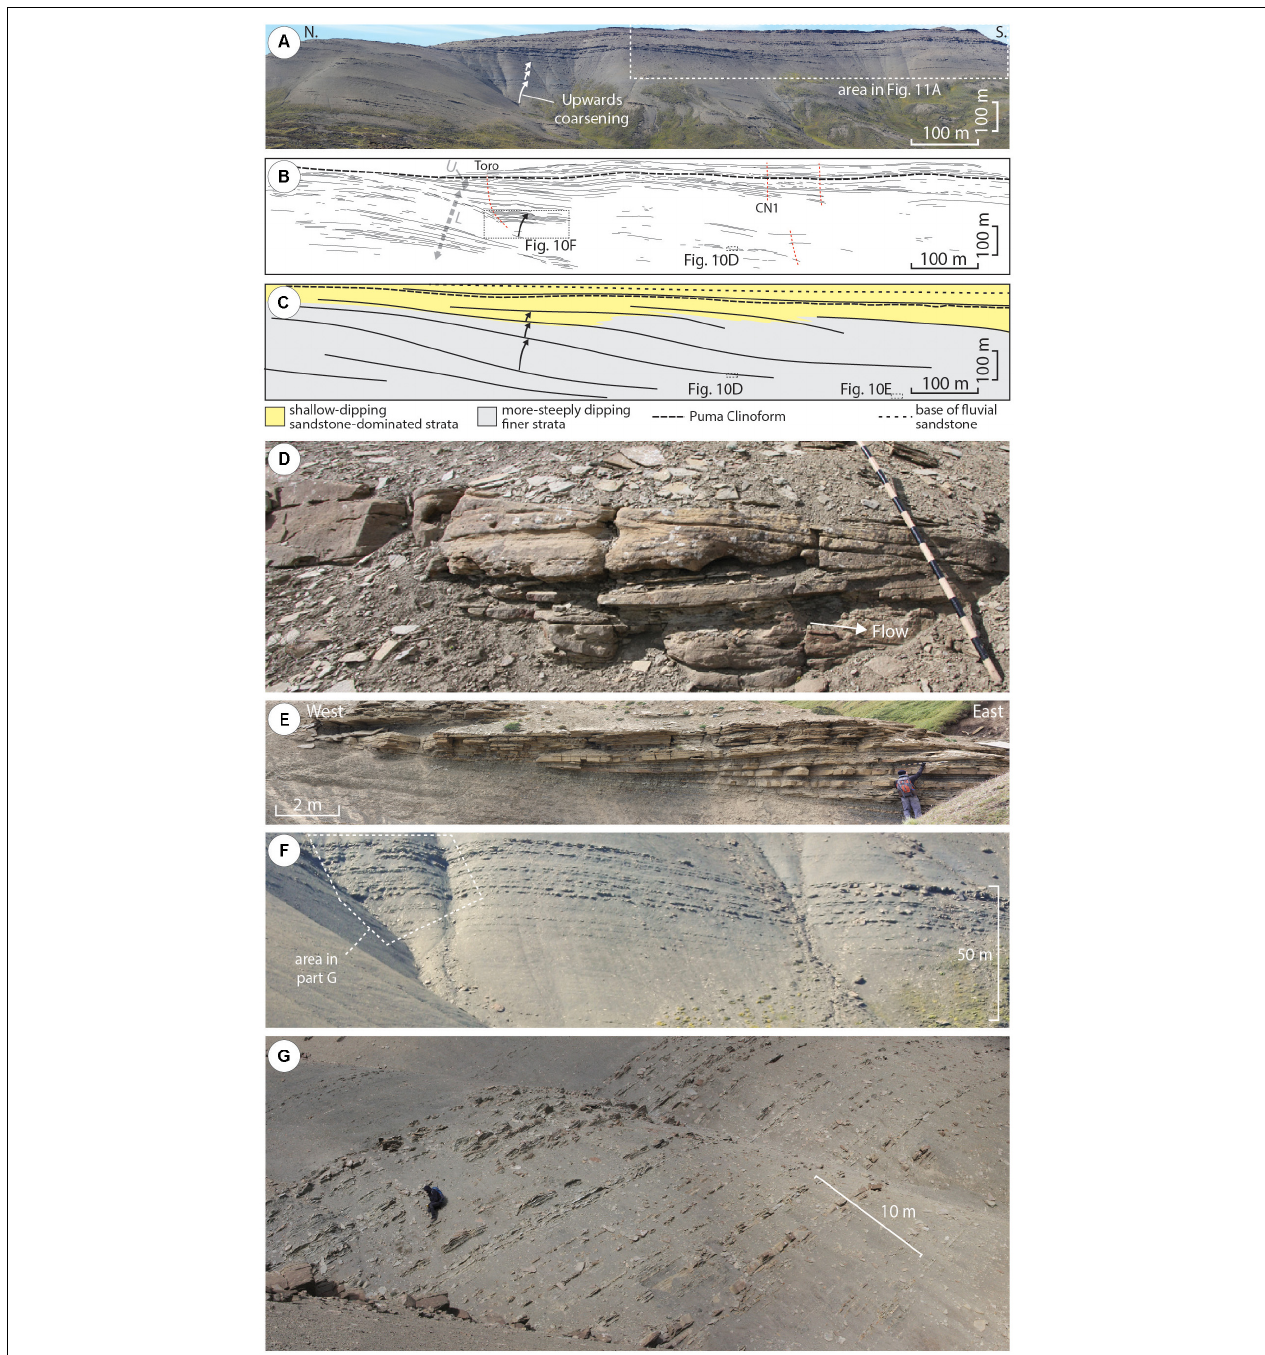
FIGURE 10 | Oveja shelf-margin stratigraphic architecture and facies. (A) Depositional dip perspective with an emphasis on coarsening upward packages (white arrows); the top of the section is dominated by sandy deposits (see Figure 2E for location). (B) Line-drawing trace of (A) , which enhances stratigraphic surfaces, including relatively shallow dipping topset strata (top of image) and more steeply dipping slope strata (middle to base of image). Gray dashed line approximates the boundary between lower (L), and upper (U) sections of the clinothem, as described. The black dashed black line demarcates the Puma clinoform. Selected measured section locations are shown with sub-vertical dashed red lines. (C) Schematic diagram showing the interpretation of stratigraphic architecture in (A,B) . (D) Non-amalgamated cross-bedded medium-grained sandstone (F6) within lenticular channel form [location shown on (C) ]. Variably oriented cross-stratification, including backsets, suggest that these bodies formed during phases of high discharge (Ponce and Carmona, 2011; Hage et al., 2018). (E) Semi- to non-amalgamated wedge, in which the beds lap out or pinch out at the basal to marginal edge of a lenticular sedimentary body [location shown on Part (C) ]. (F) Overall coarsening upward package [location shown on (B) ]. (G) Interbedded normally graded planar-laminated sandstone (F13) and carbonaceous mudstone (F1) toward the top of a thick upward-coarsening section.